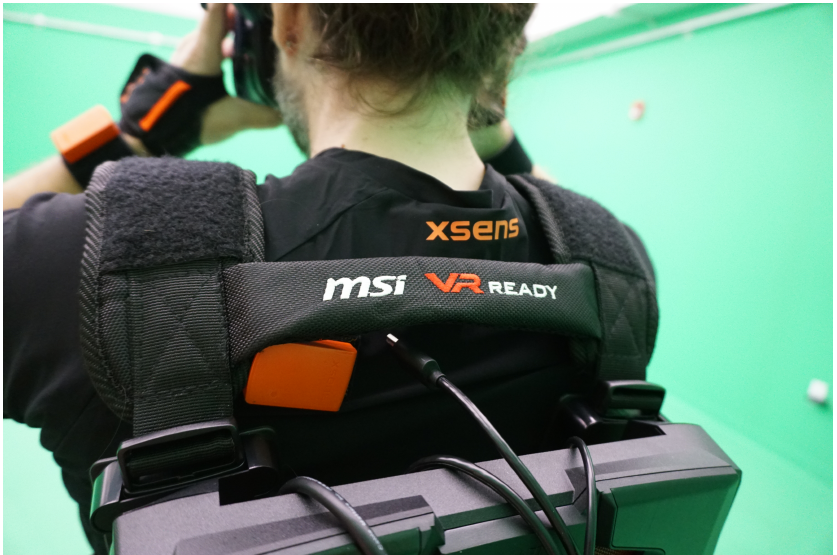
Figure 4. The participant wearing all devices (MSI VR One backpack computer, HTC Vive head-mounted display, and Xsens motion capture system) used for this